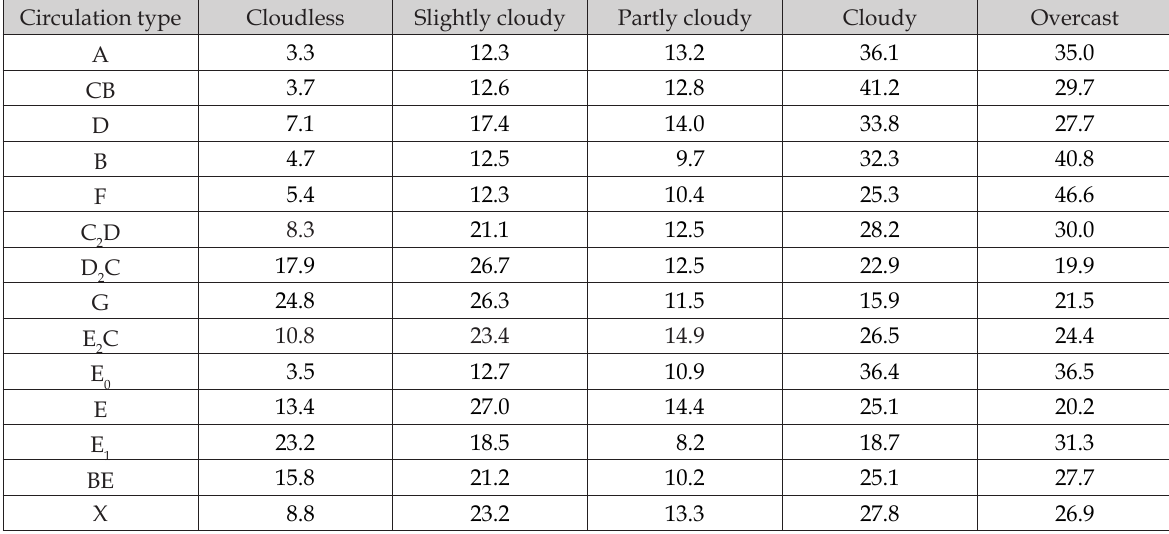
Table 5. Conditional probability (%) of occurrence of cloud cover depending on the given atmospheric circula- tion type according to Osuchowska-Klein classification in Poznań (1966–1998).